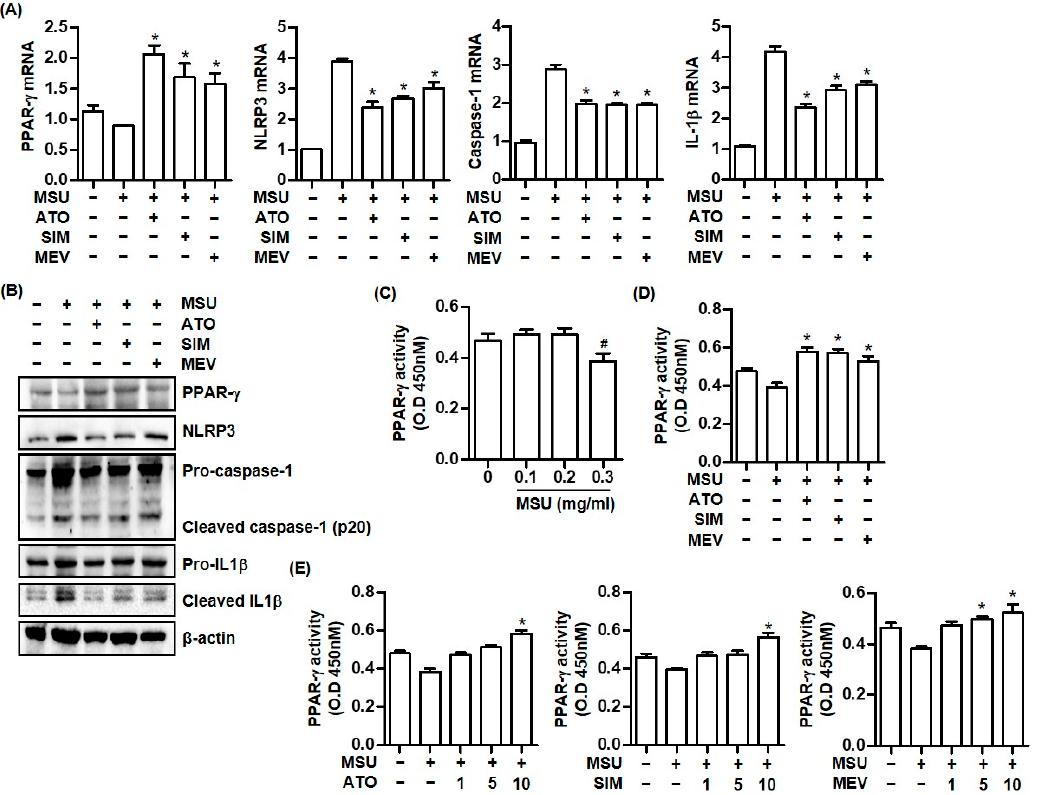
Figure 2. Statins augment PPAR- γ expression and inhibit NLRP3 in fl ammasome activation in MSU crystal-mediated in fl ammation. ( A ) PPAR- γ , NLRP3, caspase-1, and IL-1 β mRNA expression in THP-1 cells treated with atorvastatin (10 µM), simvastatin (10 µM), or mevastatin (5 µM) for 24 h under stimulation with MSU crystals (0.3 mg/mL) for 24 h. ( B ) PPAR- γ , NLRP3, caspase-1, and IL- 1 β protein expression by Western blo tt ing of supernatants and lysates from THP-1 cells treated with each statin under stimulation with MSU crystals (0.3 mg/mL) for 24 h. ( C ) PPAR- γ activity measured in nuclear extracts from THP-1 cells treated with MSU crystals (0.1, 0.2, and 0.3 mg/mL). ( D ) Meas- urement of PPAR- γ activity after addition of atorvastatin (10 µM), simvastatin (10 µM), or mevas- tatin (5 µM) in THP-1 cells stimulated with MSU crystals. ( E ) Measurement of PPAR- γ activity un- der stimulation of MSU crystlas (0.3 mg/mL) after pretreatment with multiple dosages of atorvas- tatin, simavstatin, or mevastatin. *: p < 0.05 compared to cells treated with only MSU crystals using Kruskal–Wallis test followed by Dunn’s multiple comparison test; # : p < 0.05, compared to cells treated without MSU crystals using Kruskal–Wallis test followed by Dunn’s multiple comparison test. Values presented as mean ± SEM of three independent experiments. Images are representative of three independent experiments. Abbreviations: PPAR- γ , peroxisome proliferator-activated recep- tor- γ ; MSU, monosodium urate; IL-1 β , interleukin-1 β ; ATO, atorvastatin; SIM, simvastatin; and MEV, mevastatin. 2.3. PPAR- γ De fi ciency A tt enuated the Inhibitory E ff ect of Statins on MSU Crystal-Mediated NLRP3 In fl ammasome Activation We assessed how PPAR- γ a ff ected NLPR3 in fl ammasome-induced in fl ammation upon stimulation with MSU crystals. Macrophages transfected with PPAR- γ siRNA mark- edly induced MSU crystal-induced caspase-1 and IL-1 β mRNA expression, compared with cells transfected with NC siRNA but not with NLRP3 mRNA (Figure 3A). Further- more, in cells transfected with PPAR- γ siRNA, all HMG-CoA reductase inhibitors includ- ing atorvastatin, simvastatin, and mevastatin signi fi cantly augmented NLPR3, caspase-1, and IL-1 β mRNA expression, compared with non-transfected cells. Consistently, NLPR3, caspase-1, and IL-1 β protein expression was much higher in macrophages transfected